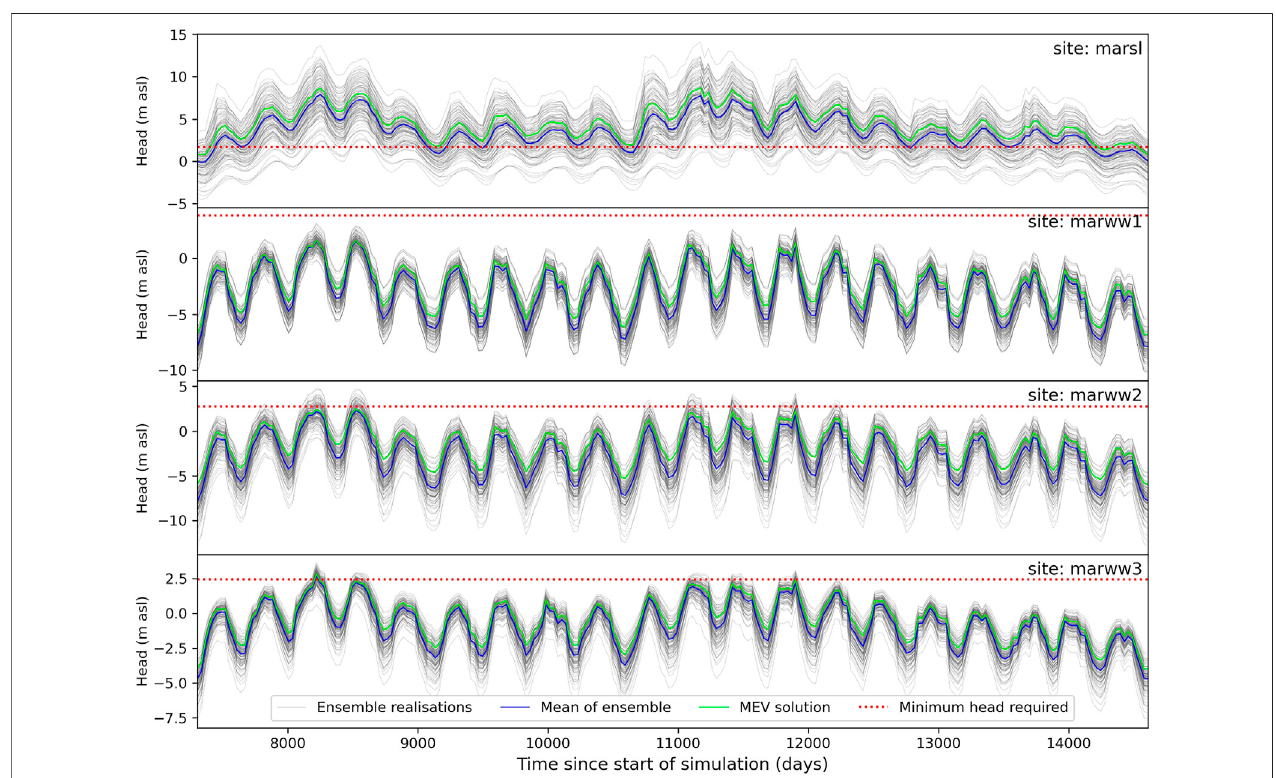
FIGURE 8 | Predicted hydraulic heads at MAR locations, showing MEV model results (green), each ensemble member (grey), mean of ensemble (blue), and the minimum head requirement at that location (red dashed).